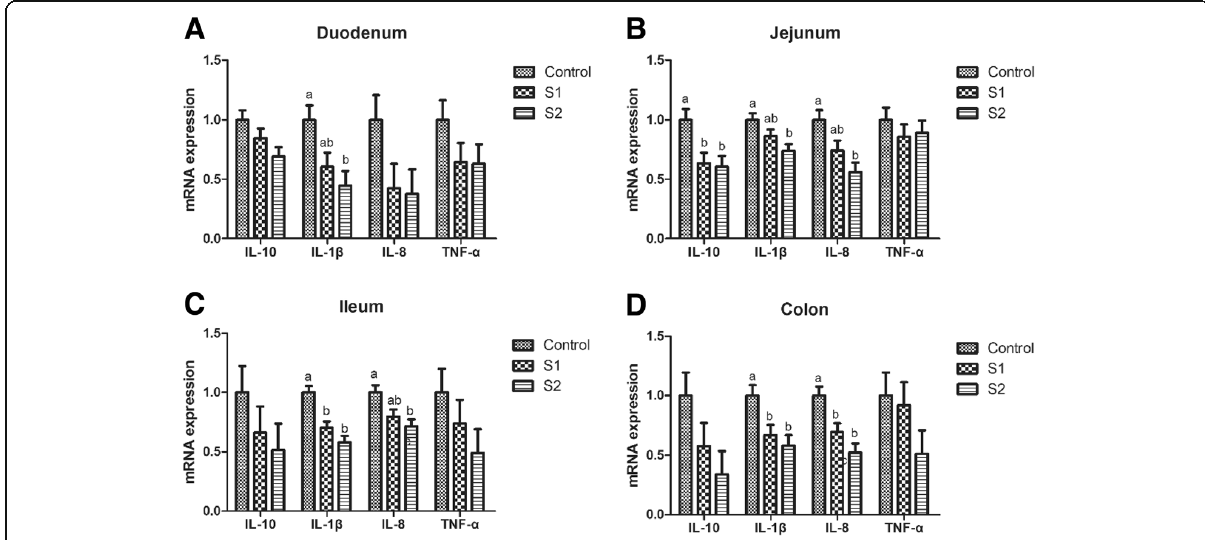
Fig. 6 Effect of gastric infusion of SCFA on the relative mRNA expressions of inflammatory factors in duodenum, jejunum, ileum, and colon of weaned piglets. S1, pigs treated with SCFA (acetic, propionic, and butyric acids; 20.04, 7.71, and 4.89 mM respectively); S2, pigs treated with SCFA (acetic, propionic, and butyric acids; 40.08, 15.41, and 9.78 mM respectively). a, b, means without a common superscript differ ( P <